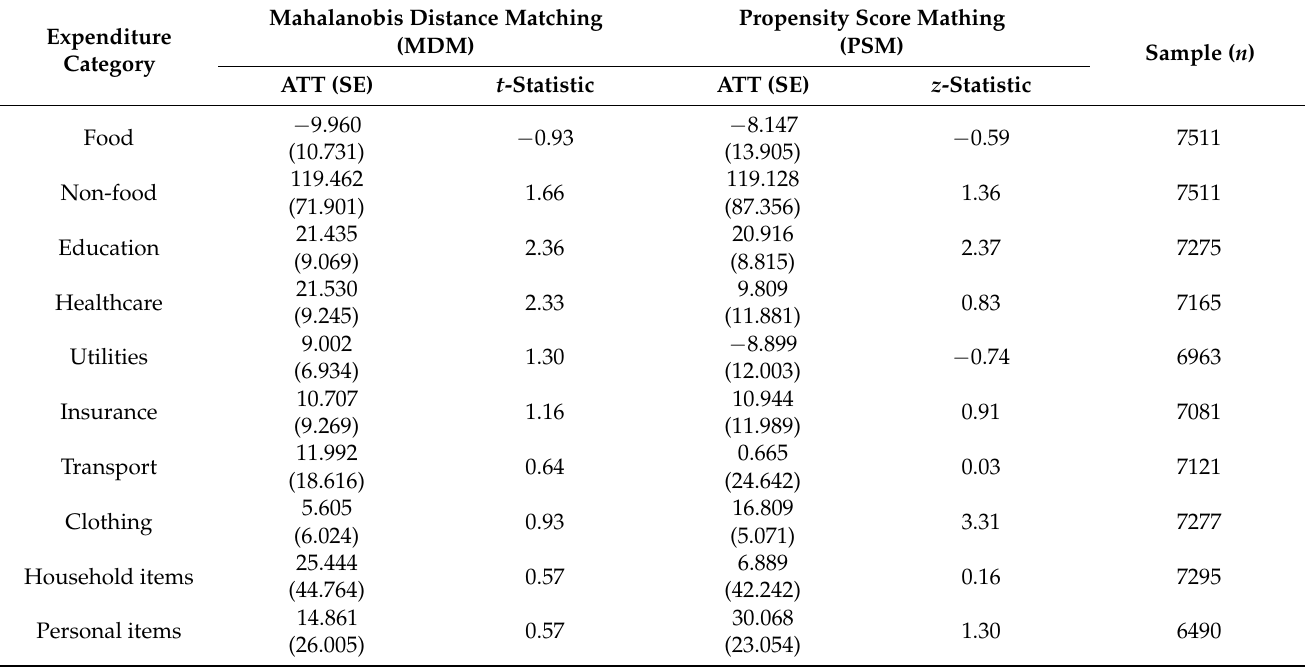
Table A1. Effect of decision-making power on monthly per capita household expenditure for MDM and